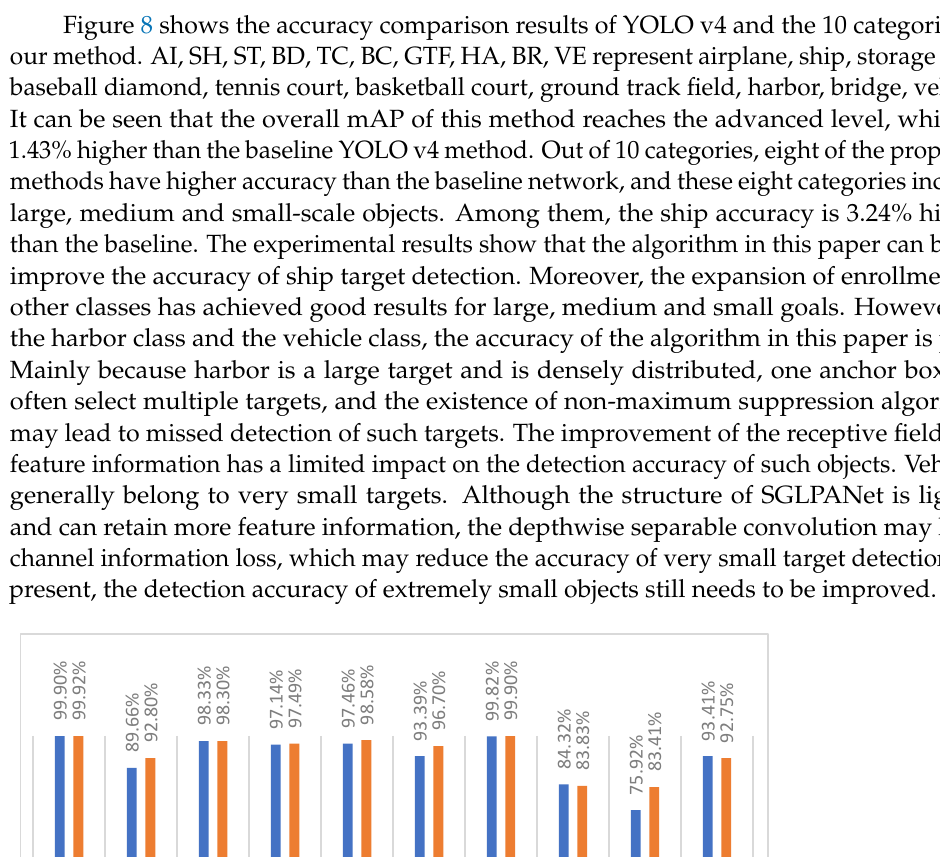
Table 3. Comparison results with other methods.